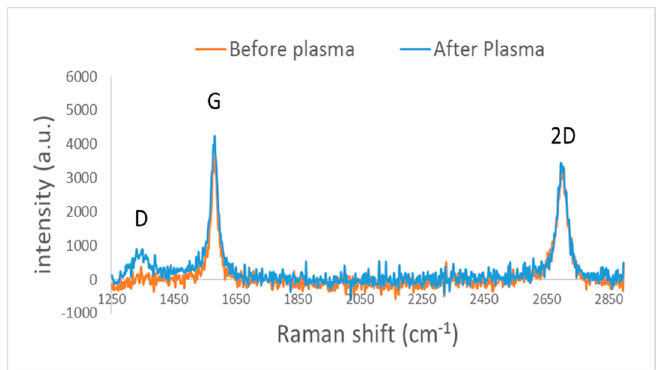
Figure 2. Raman spectra of the few-layered graphene film deposited on a SMR before and after the low damage O 2 treatment. Note the appearance of the defect D peak after the plasma